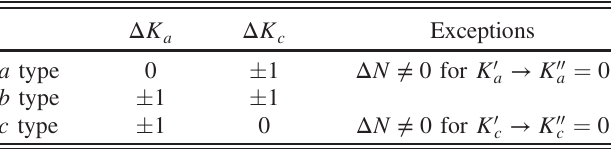
TABLE IV. Selection rules in the dipole approximation for